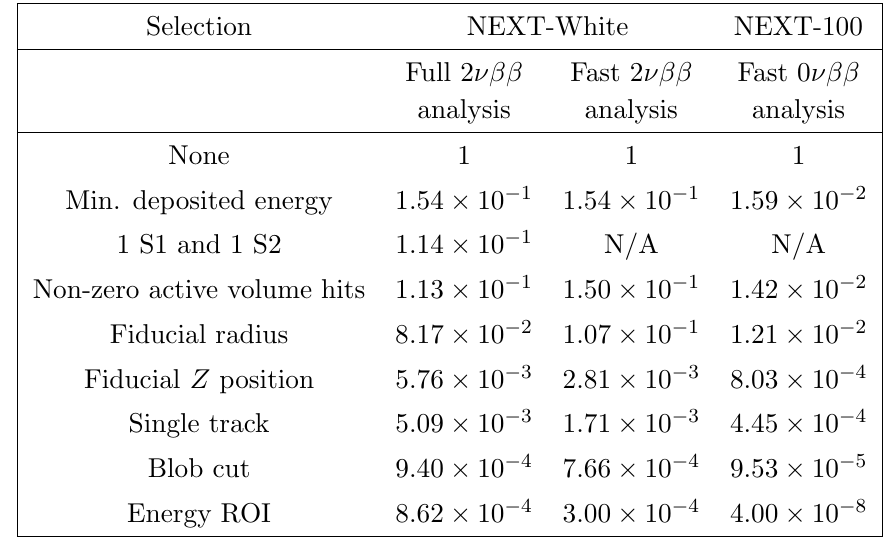
Table 5 . Cumulative e(cid:14)ciencies through the various event selection criteria, for simulated cathode 214 Bi decays in NEXT-White and NEXT-100 at 15 bar pressure. For NEXT-White (NEXT-100), the event selection corresponds to the 2 (cid:23)(cid:12)(cid:12) (0 (cid:23)(cid:12)(cid:12) ) criteria.